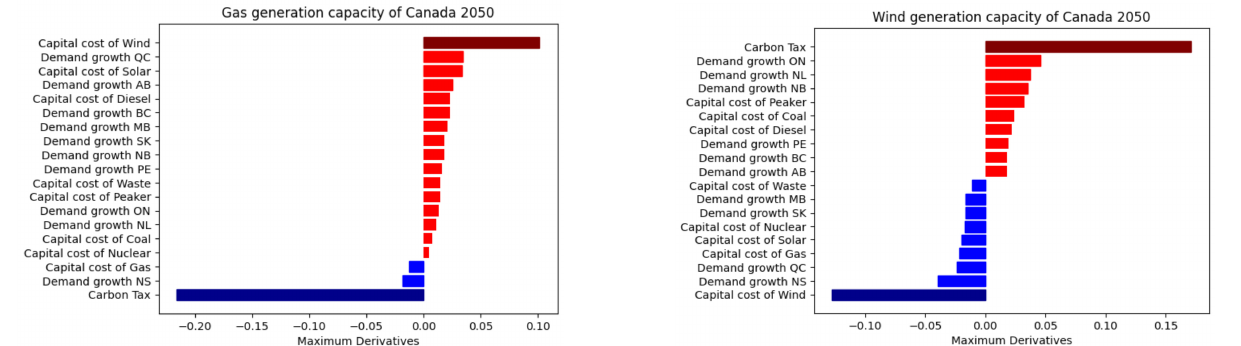
Figure 8. National Gas and Wind Generation Capacity in 2050. Ranked factors affecting Canadian gas and wind generating capacities in 2050 are presented in bar charts. These are quantitative measures of the relative impact of system inputs on two key components of the Canadian energy supply mix, with the parameters listed on the y -axis. These values, which show correlation intensity, are normalized maximum derivatives of gas and wind capacities with respect to each input on the y -axis. The negative values show the negative correlations, positive values show positive correlations, and the absolute values of maximum derivatives represent the correlation intensity.